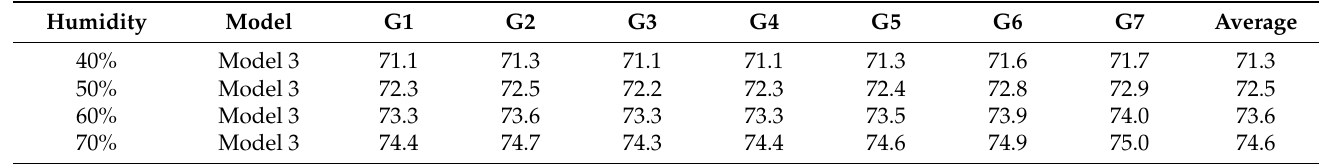
Table 6. THI of Model 3 in groups at v = 6